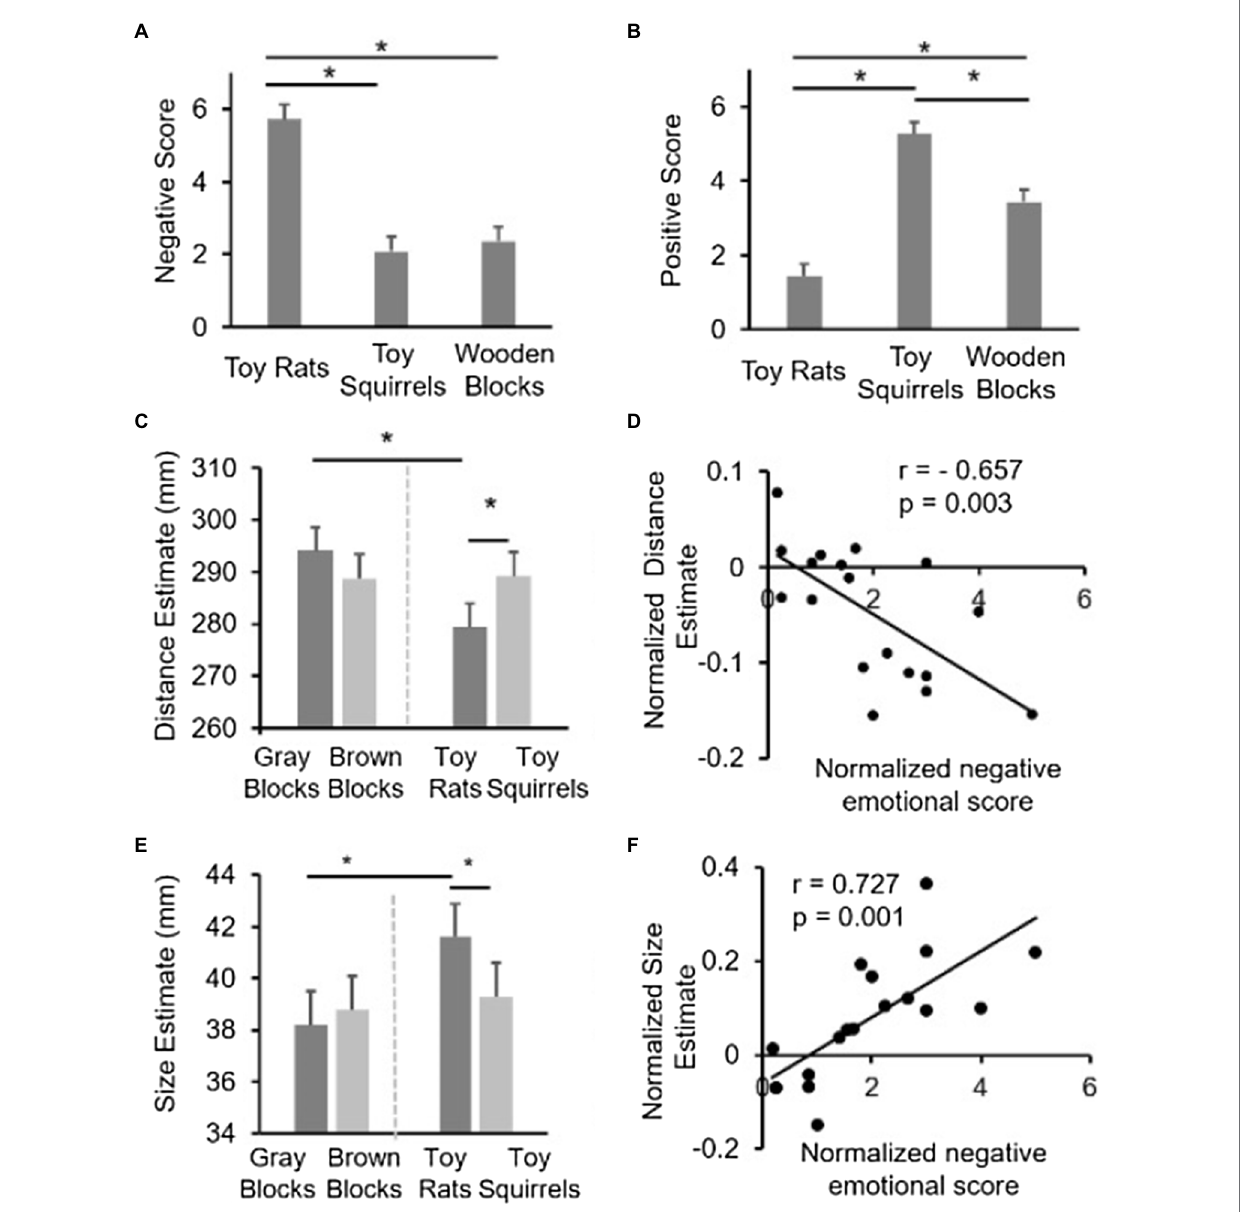
FIGURE 2 | Results of Experiment 1. (A,B) show the data of emotional arousal scores. (C,E) show the size estimation and distance estimation results. Error bars represent within-subjects 95% CIs (Loftus and Masson, 1994; Masson, 2003). (D,F) show the correlation between the relative distance/size estimation and the relative emotion scores across